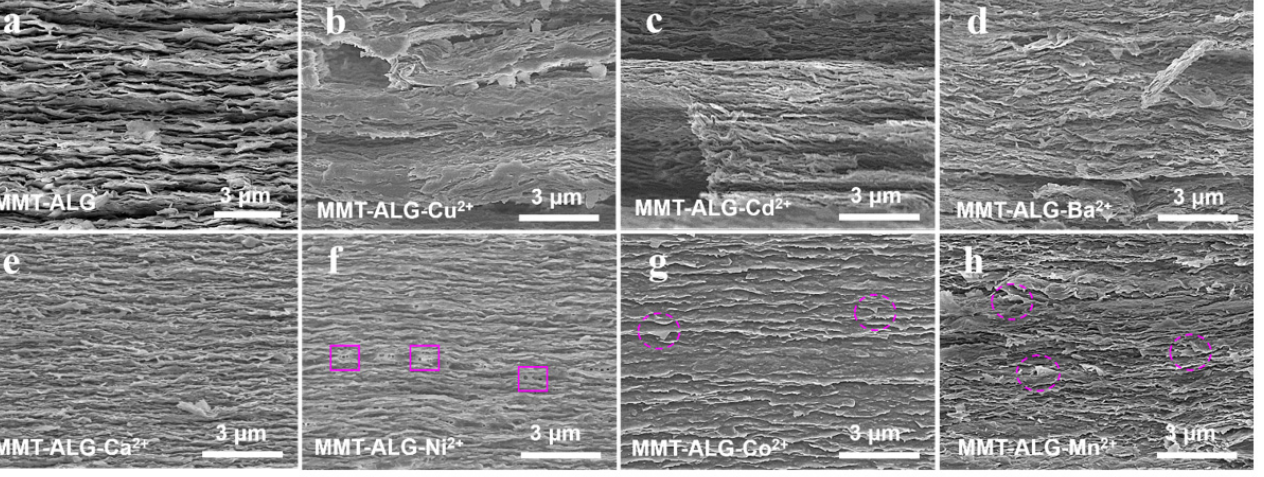
Figure 2. SEM images of the MMT-ALG ( a ) and MMT-ALG–X 2+ ( b – h )